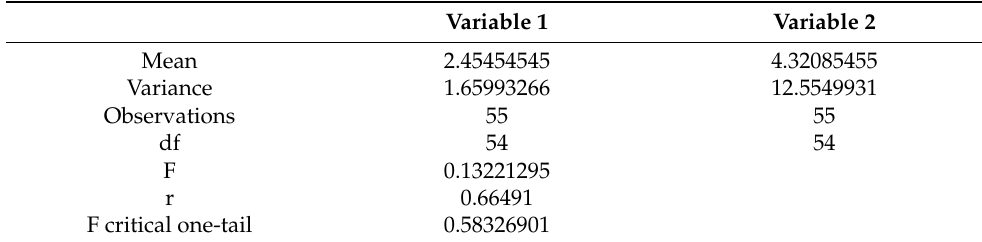
Table 4. Fisher ´ s two-sample F-test for variances (for